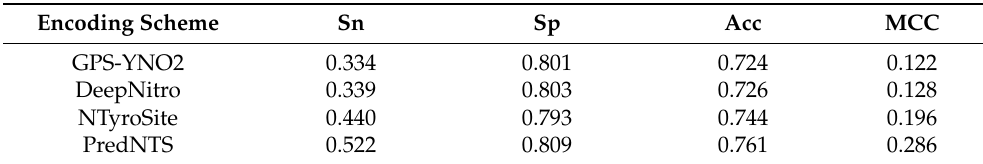
Table 6. Performance comparison of the PredNTS with the three existing predictors on the indepen- dent